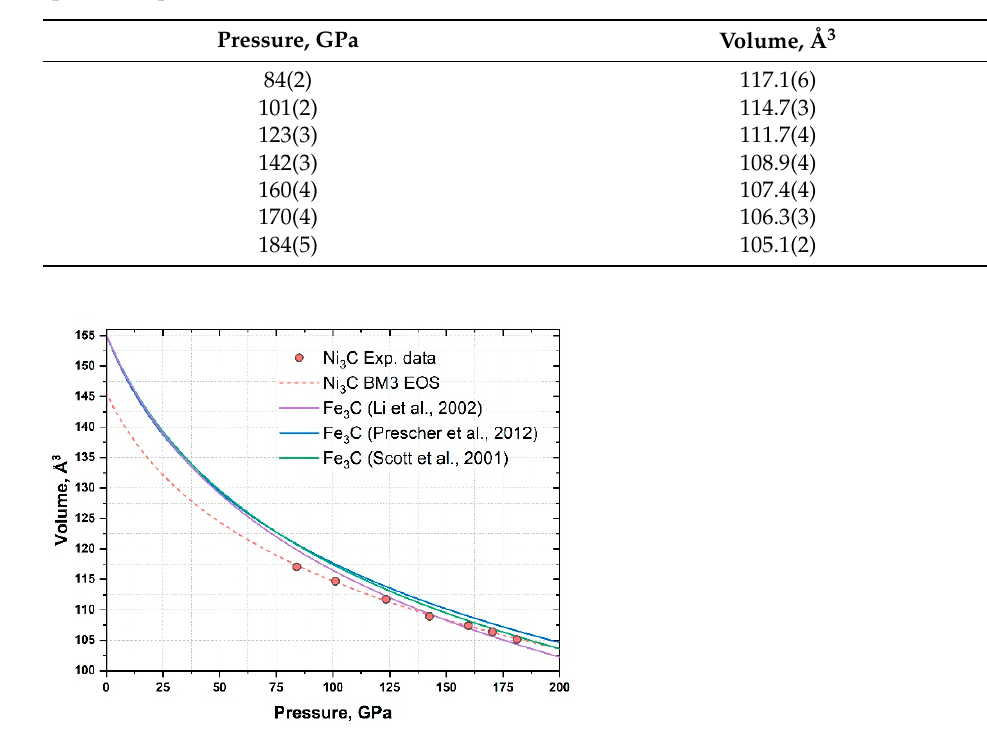
Table 2. The pressure dependence of the unit cell parameter of Ni 3 C. Values in parentheses corre- spond to experimental uncertainties.